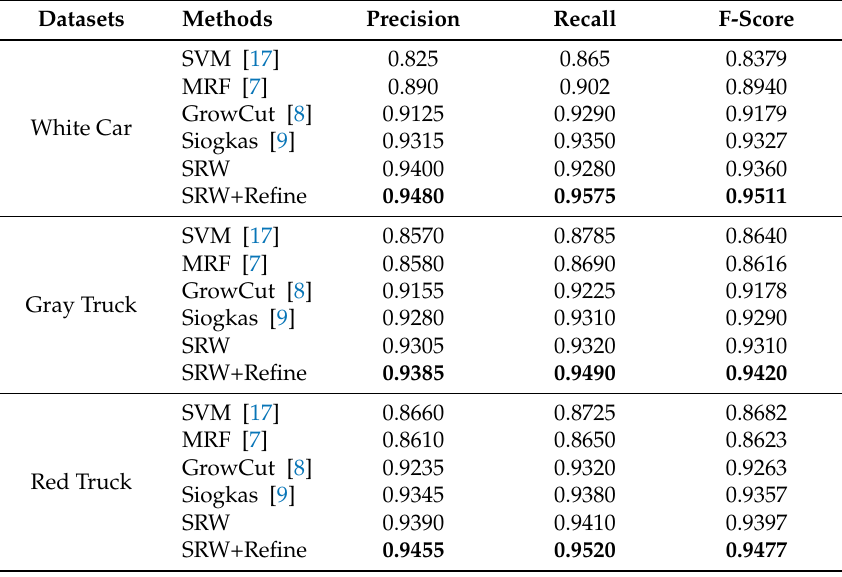
Table 5. Evaluation of foreground detection results.